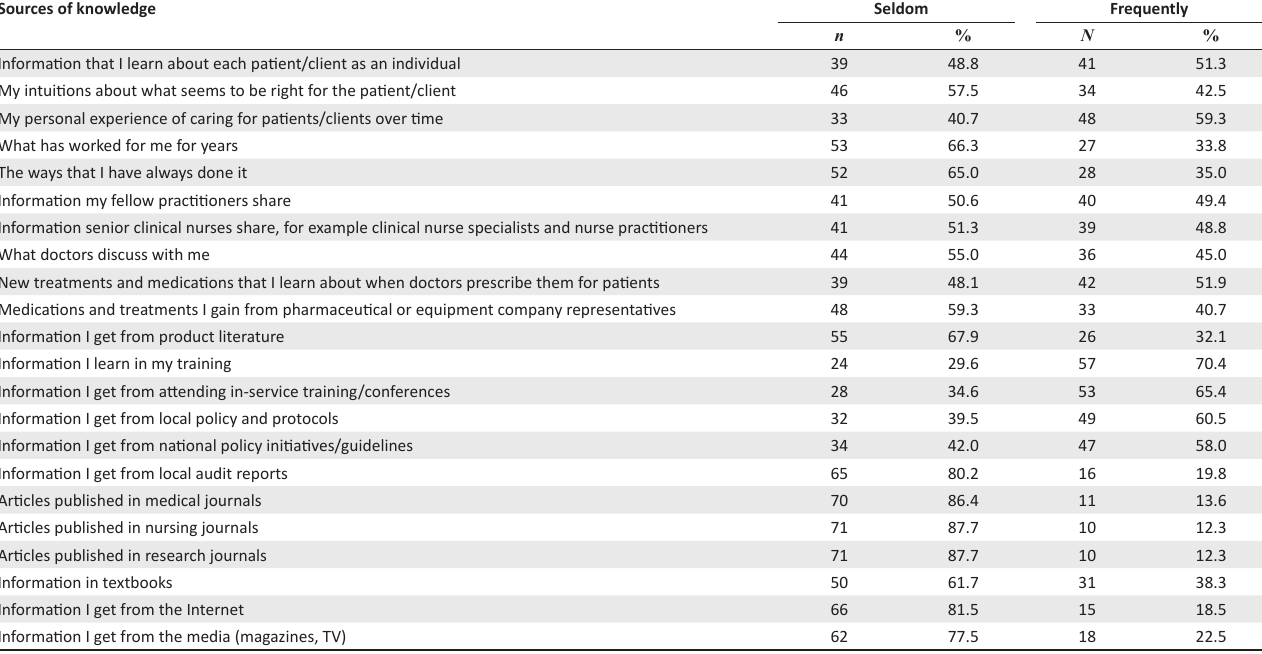
TABLE 2: Sources of knowledge for prevention of mother-to-child transmission practice. Sources of